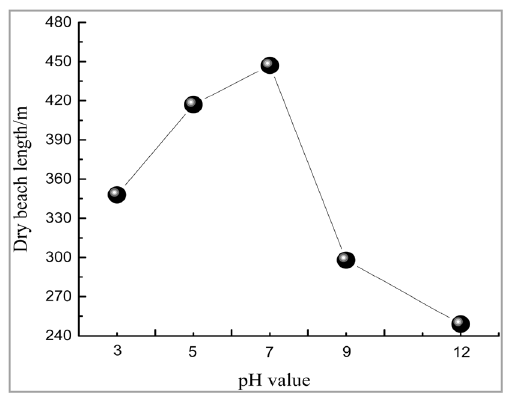
Figure 6. Variation trend line of dam dry beach length with pH values.